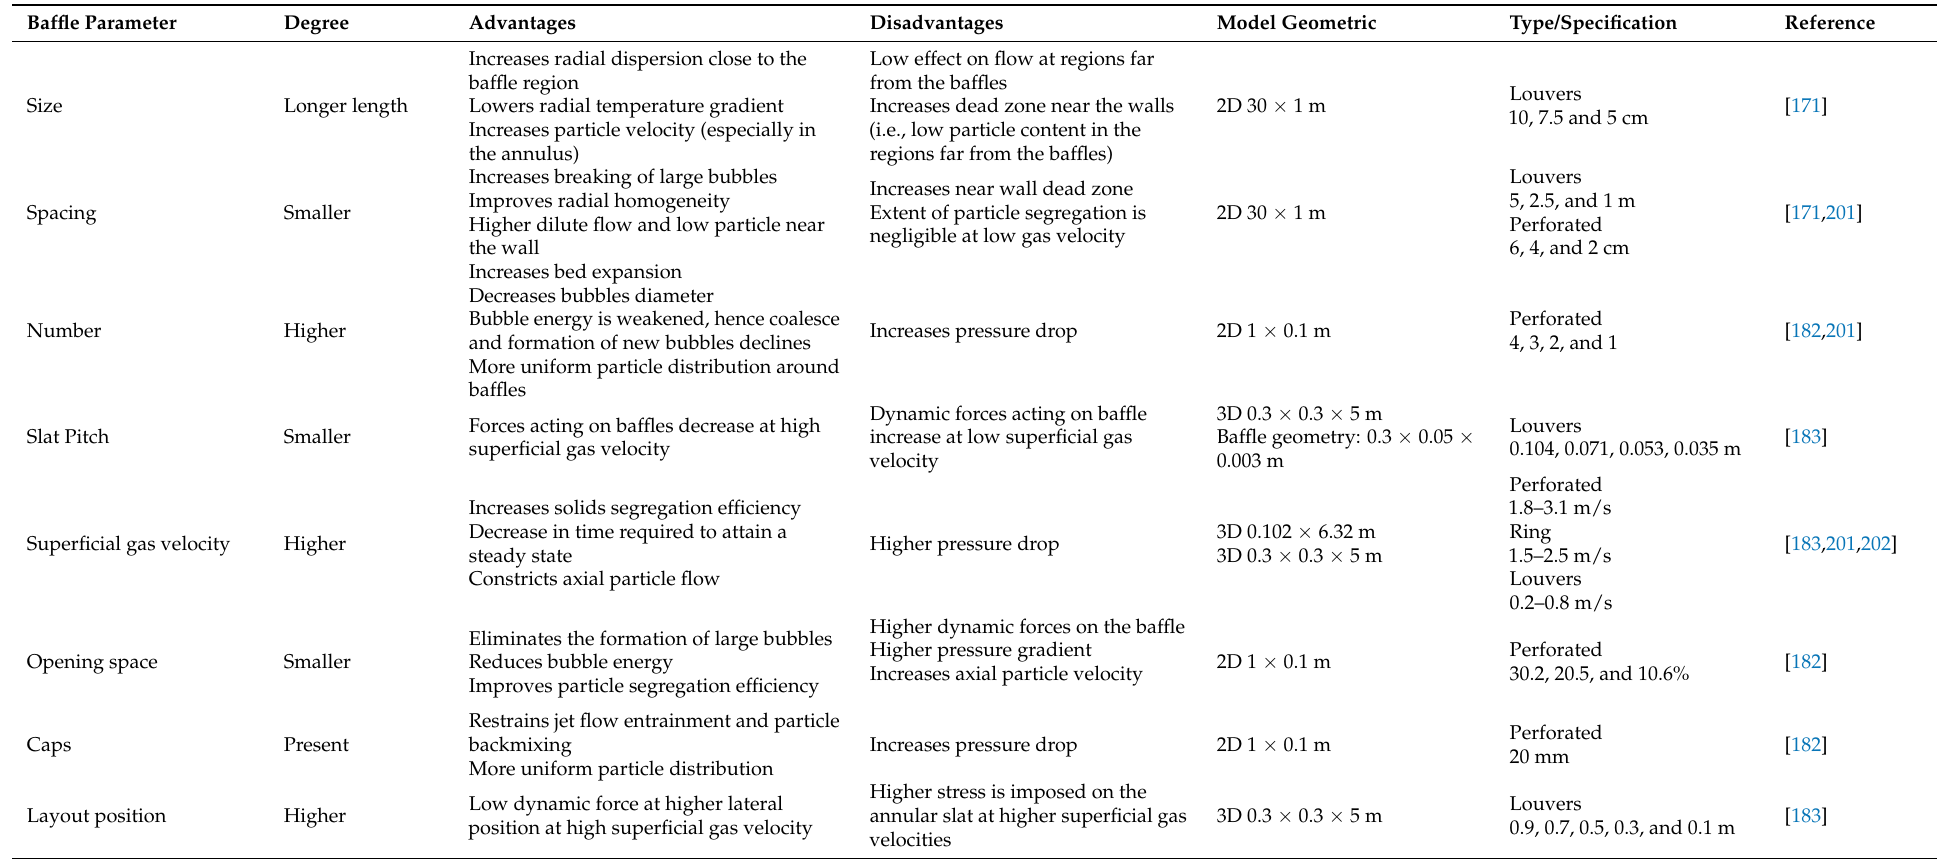
Table 6. Effects of horizontal baffles on FCC regenerator